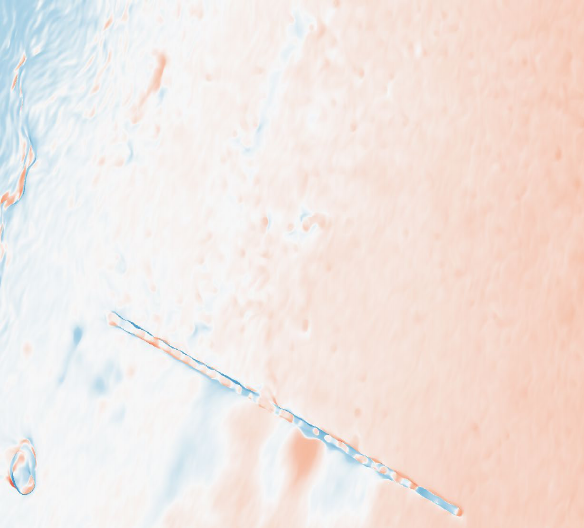
Figure 16 – Erosion / Accretion Map for the two Surveys of Figure 15 (48 hours